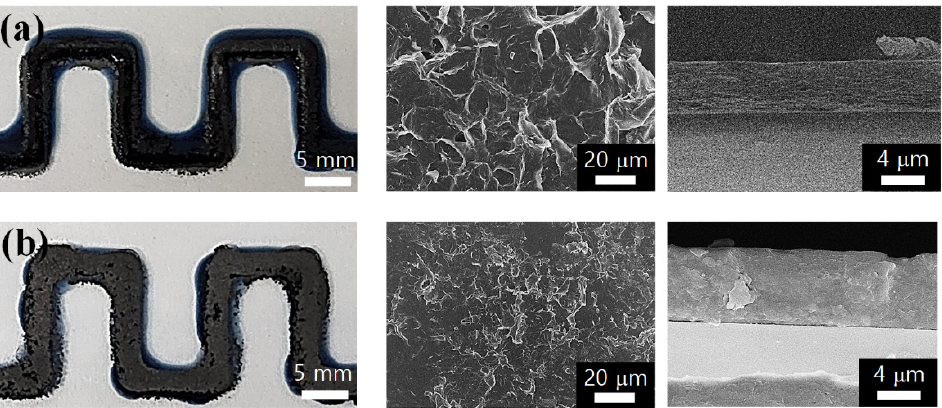
Figure 6. Photo and SEM images (surface and cross-section) of ( a ) P-G-P and ( b ) P-G-P-G composite electrodes on the glass substrate.